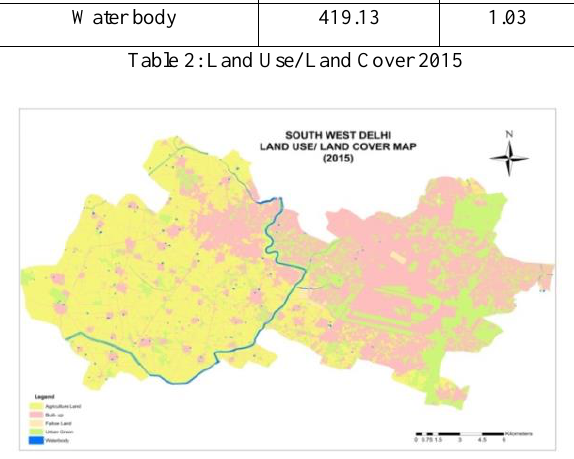
Figure 4: Land Use/ Land Cover Map 2015